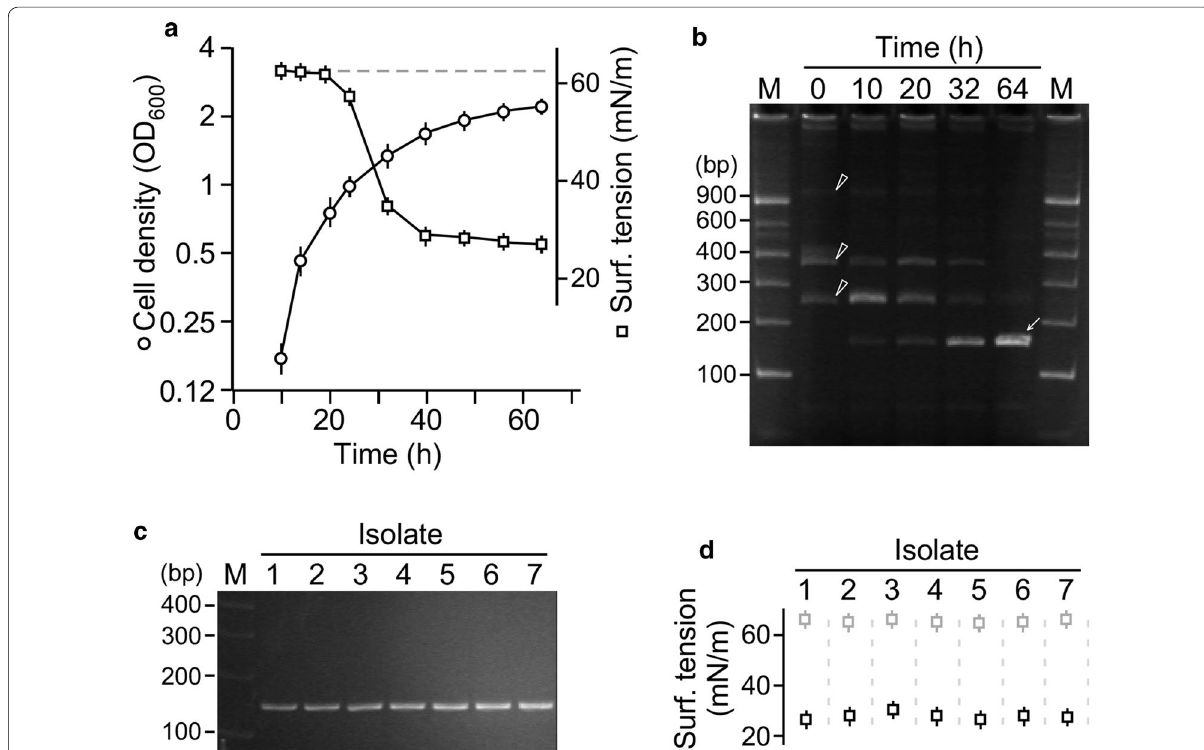
Fig. 1 Identification of biosurfactant activity in mixed microbial cultures derived from oil sludge. a Surfactant activity is detected in supernatant of cultures originated from oil sludge. X - and Y -axis indicate the time and cell density (OD 600 ) of the culture. Inset indicates the surface tension (mN/m) at various time points. The horizontal dash line indicates the surface tension of the fresh medium. b Dynamics of individual microbial populations. TFL-RFLP analysis of oil sludge-derived cultures at various time points. Arrowhead and arrow indicate the initial (at 0 h) and final (at 64 h) microbial populations, respectively. c Characterization of microbial isolates from cultures 64 h after growth. TFL-RFLP analysis of individual isolates, identical to those observed at 64 h in (B). d Biosurfactant activity produced by individual isolates. Surface tension of individual isolate cultures ( black square ) and fresh medium ( grey square